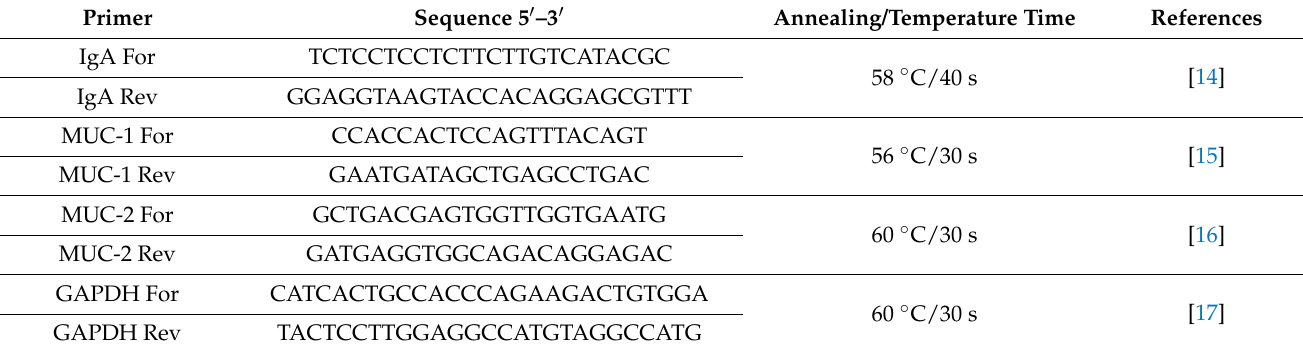
Table 1. List of primers used in qRT-PCR for IgA, MUC-1 and MUC-2 mRNA detection in mice. Primer